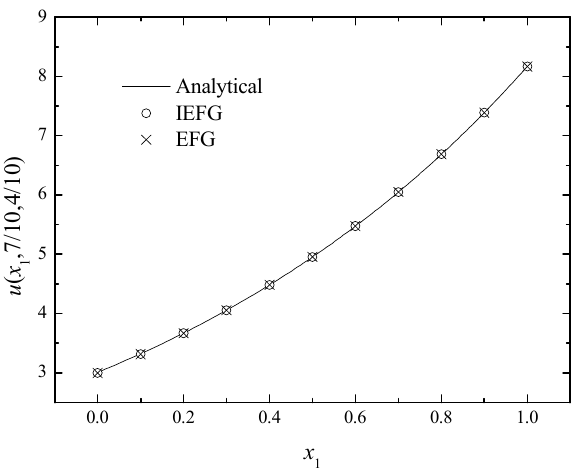
Figure 8. The comparison of numerical and exact solutions along x 1 -axis.